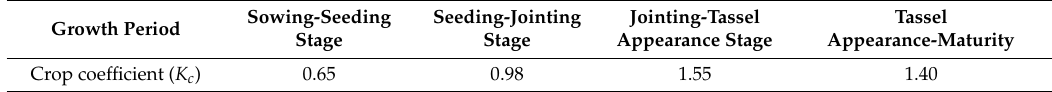
Table 2. Crop coefficient of summer maize in different stages in the BHR.